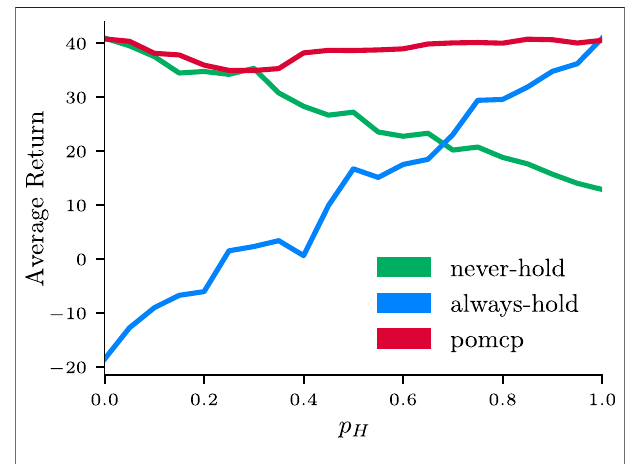
FIGURE 7 | Comparison of the proposed strategy (red) against an “ Always Hold ” (green) and a “ Never Hold ” (blue) strategy during simulated interactions with varying degree of user preferences. For each of them, average return values and standard deviations with respect to the probability of the “ Hold ” preference p H are shown. The three strategies are tested against a single “ Assemble Leg ” subtask (see Figure 1 , bottom) with 20 different values of p H , ranging from 0.0 (i.e., the human never wants the robot to hold) to 1.0 (i.e., the human always like the robot to hold). For each of the 20 different preferences, the results are averaged from 100 simulated interactions, for a total of 6,000.